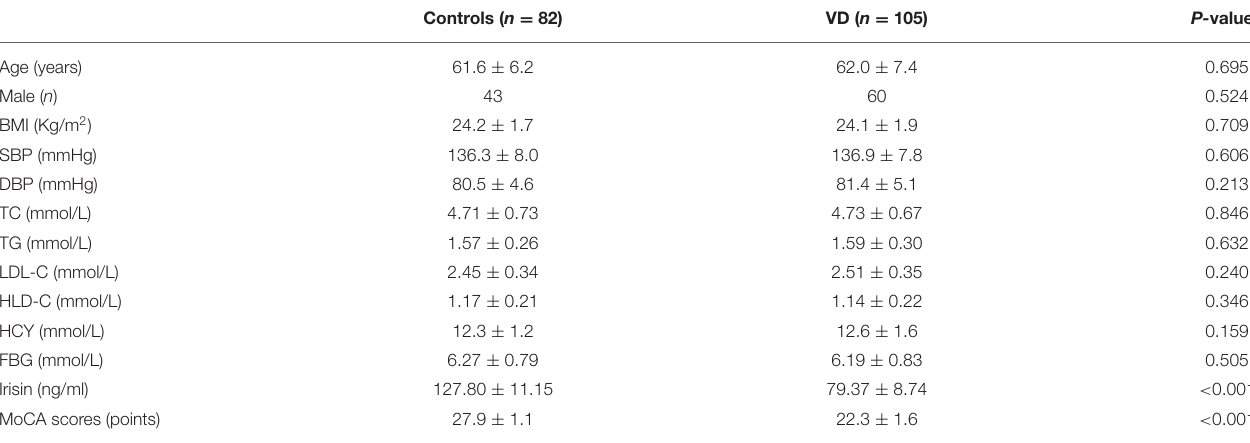
TABLE 1 | Baseline clinical characteristics of all subjects.